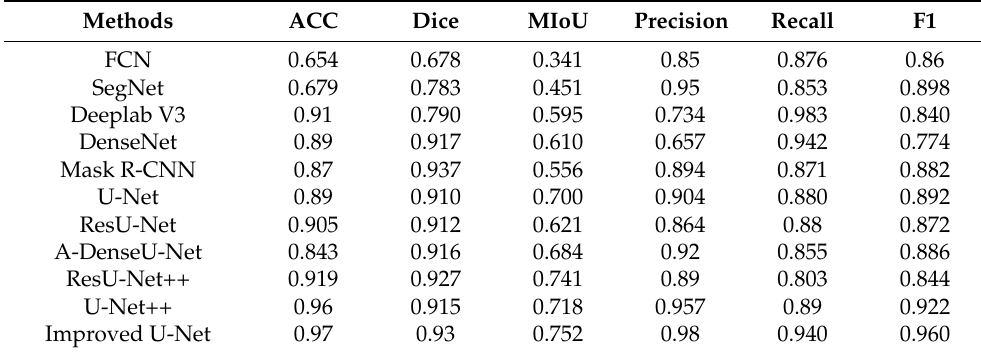
Table 3. The metrics’ results of different segmentation